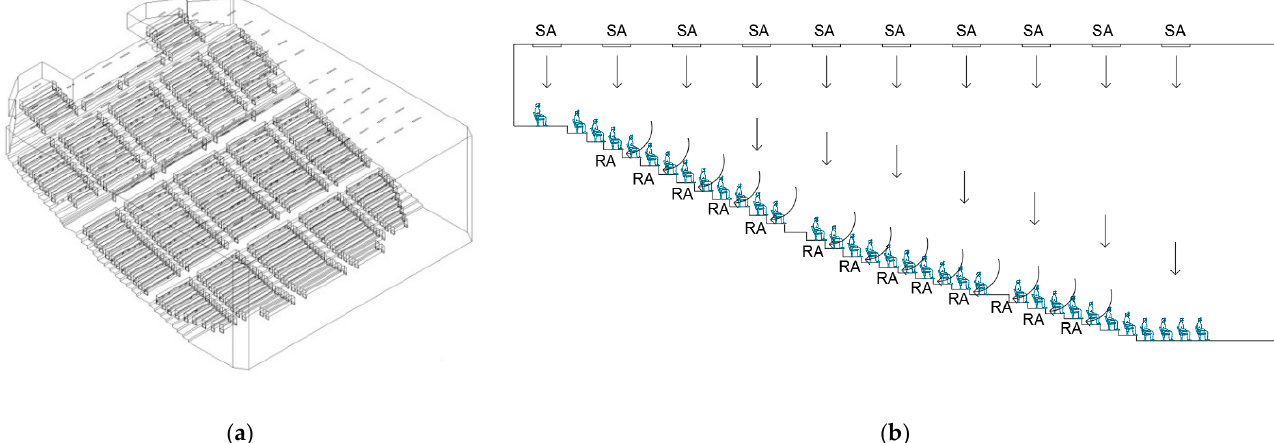
Figure 1. The investigated conference hall: ( a ) geometry and ( b ) schematic diagram.